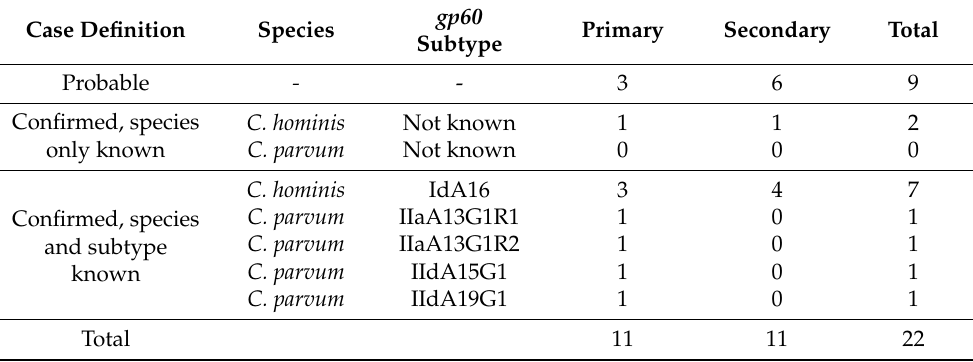
Table 1. Outbreak-associated cases of confirmed and probable cryptosporidiosis, North East England, 2016 (n =